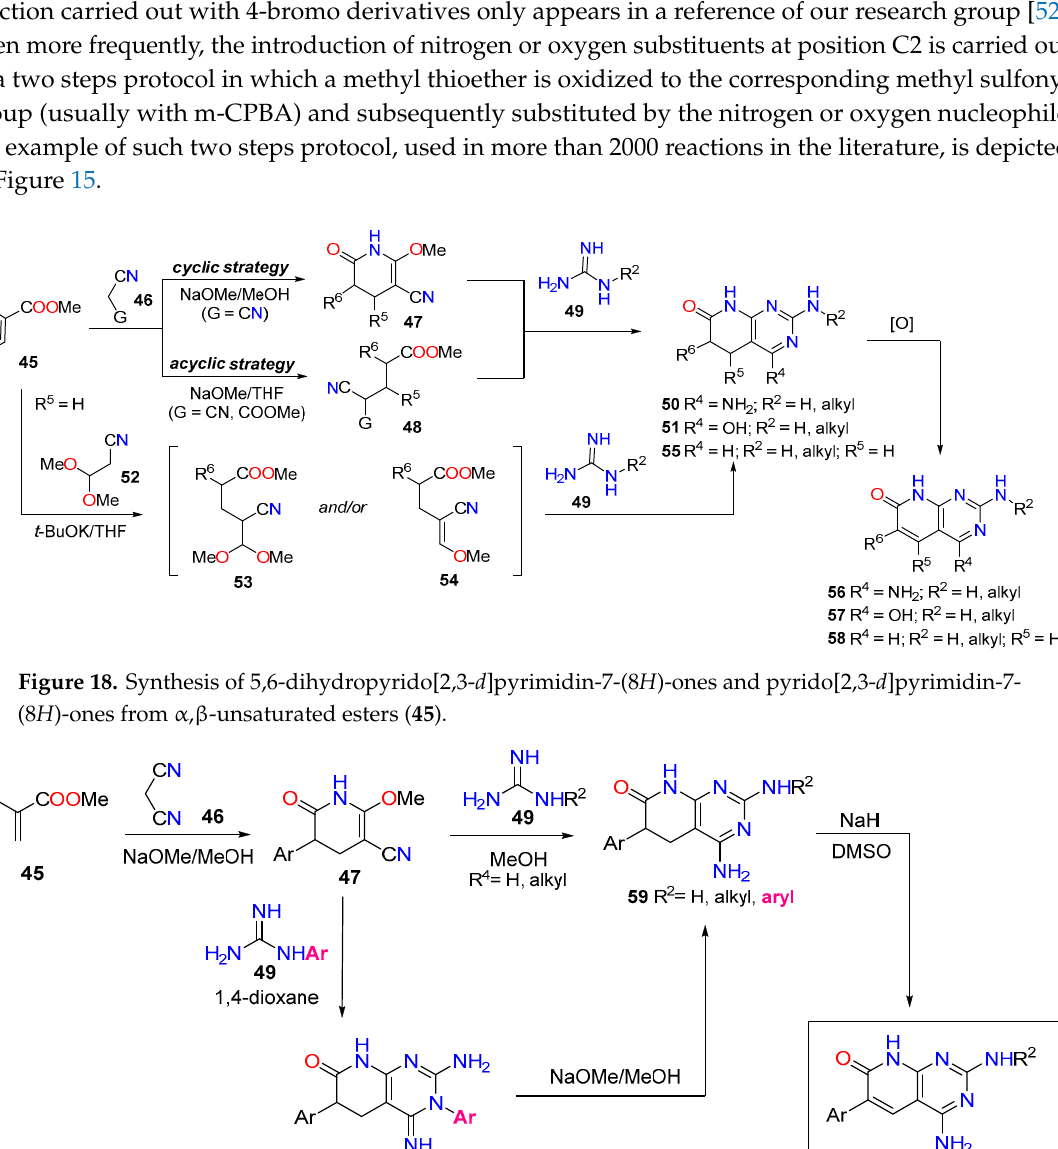
Figure 19. Synthesis of 6-aryl-2-arylamino substituted 4-amino-5,6-dihydropyrido[2,3- d ]pyrimidin- 7(8 H )-ones ( 59 ) from α , β -unsaturated esters ( 45 ) .